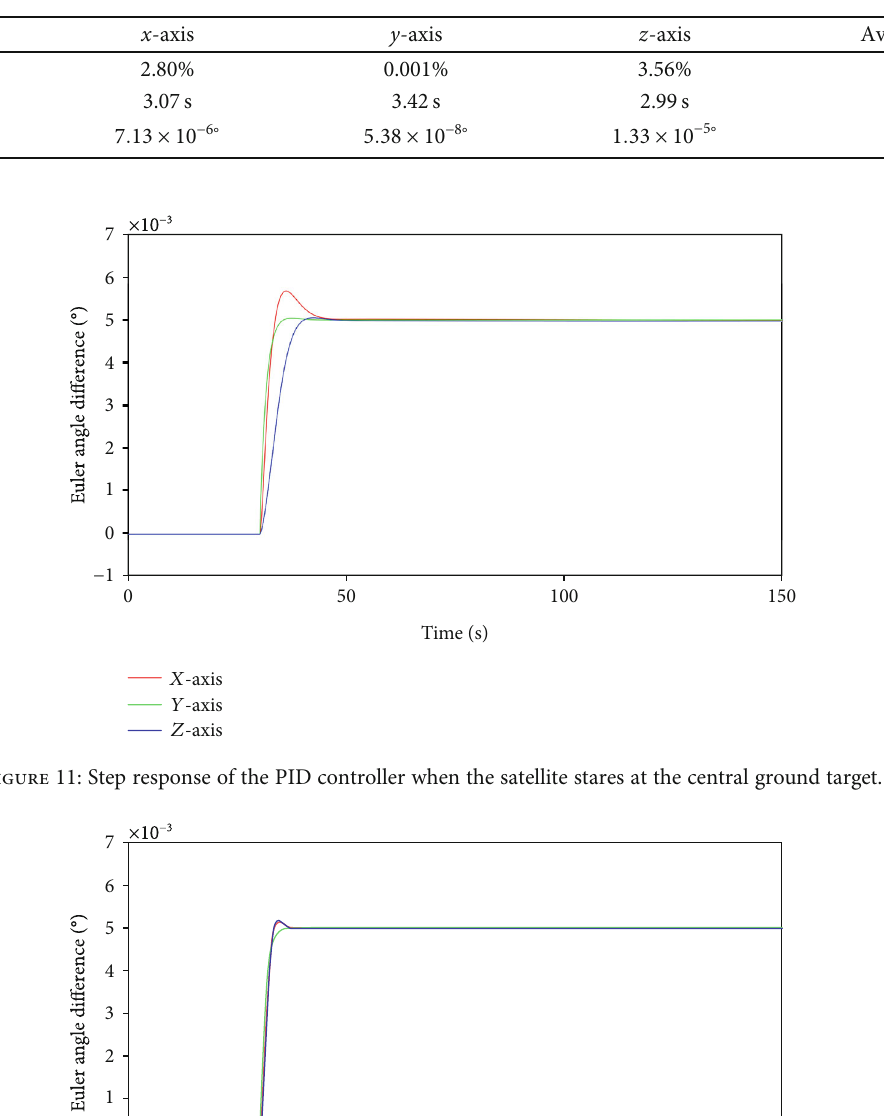
Table 11: Average step response performance of the neural network controller for all the ground targets.